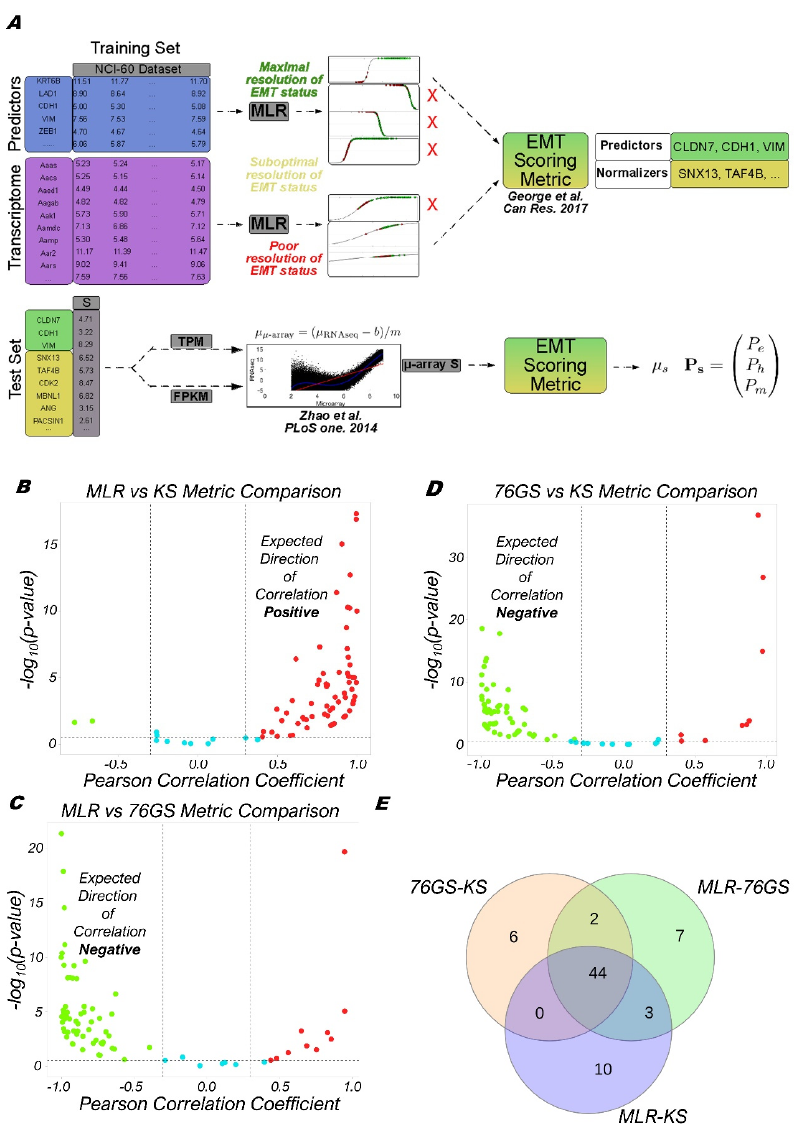
Figure 1. Schematic of the interconversion of MLR microarray and MLR RNA-seq scores and pairwise correlation plots of the three EMT scoring metrics. ( A ) Adaptation of microarray-based MLR approach to predict RNA-seq-based input. Predictors (resp. normalizers) in the NCI-60 microarray training set were selected as performed previously, based on their ability (resp. inability) to resolve the EMT status of the training set. Poor candidates (red X) in each case were omitted from inclusion in the proctor and normalizer set. Histograms (teal bars) and corresponding spline interpolate density function estimates (black curves). Linear regression between RNA-seq and microarray data given in Zhao et al. 2014 was used to relate a unique value of RNA-seq signal to the microarray-based model, conducted for both FPKM and TPM values. ( B – D ) Plots showing the pairwise correlation of EMT scoring metrics across 77 bulk RNA-Seq datasets, and for each sample –log 10 ( p -value) is plotted as a function of Pearson’s correlation coefficient. Thresholds considered for correlation ( R < − 0.3 (green points) or R > 0.3 (red points); vertical dashed grey lines) and p -values ( p < 0.05; horizontal dashed grey lines) are denoted. Cyan points represent cases for which R > − 0.3 and R < 0.3. ( E ) Venn diagram depicting the overlap of pairwise and full concordance for datasets that are significantly correlated in the expected